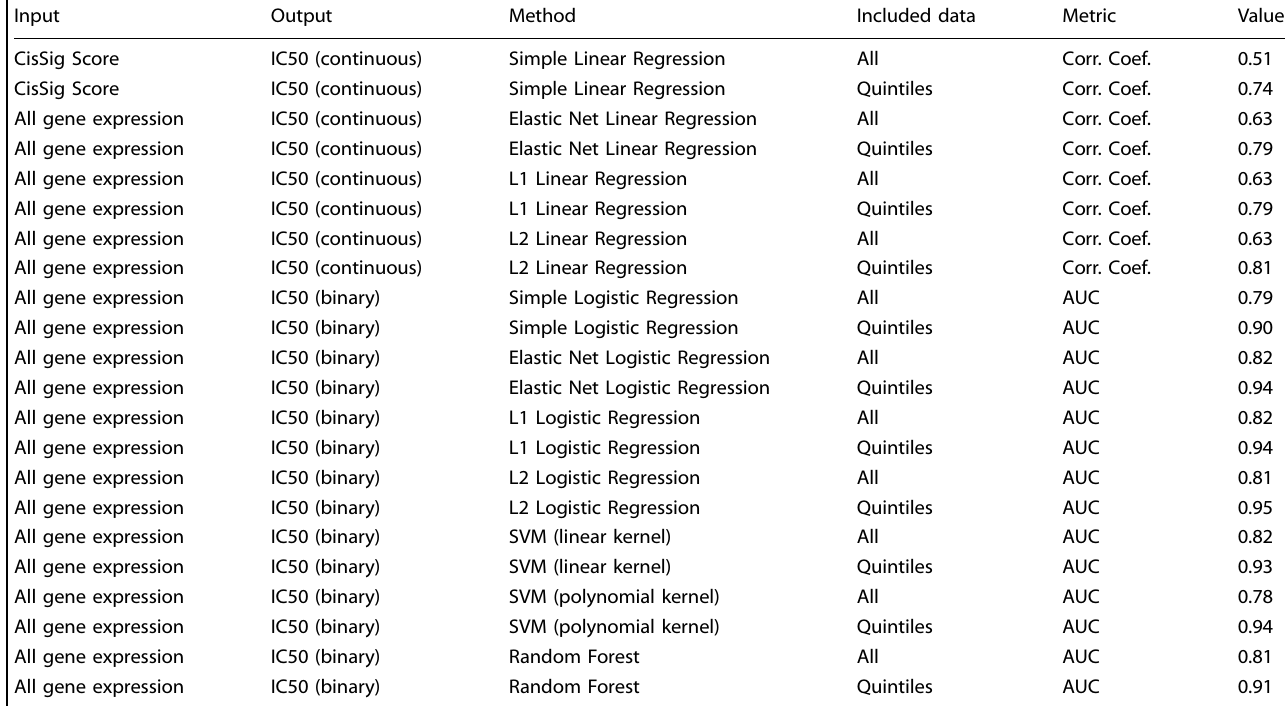
Table 2. Model details and validation results for the prediction of cisplatin response using CisSig in GDSC